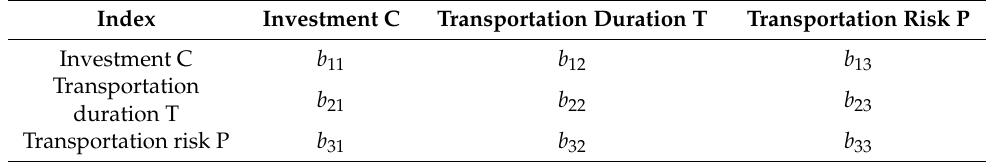
Table A1. Pairwise comparison table of criteria.